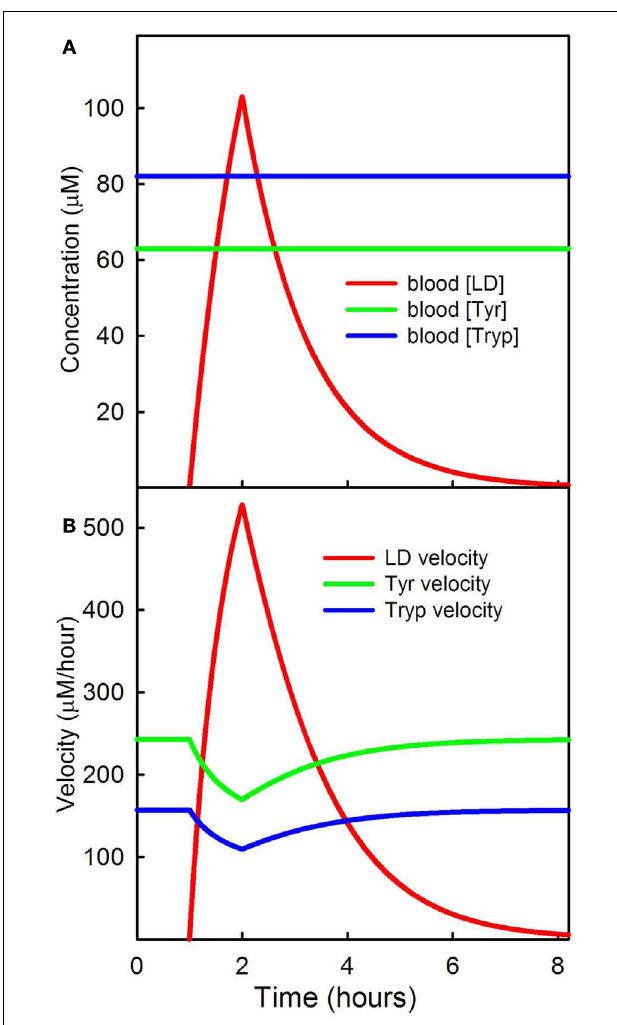
FIGURE 2 | LD competition with tyrosine and tryptophan at the BBB. (A) Shows the serum levels of a dose of LD; the concentrations of tyrosine and tryptophan are assumed constant. (B) Shows the transport velocities of LD, tyrosine, and tryptophan, across the BBB as a function of time.